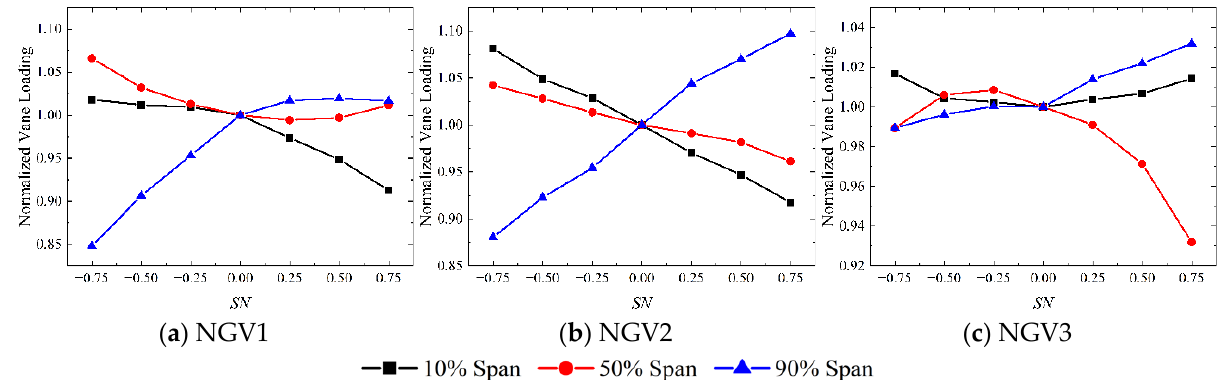
Figure 15. Effect of swirl intensities on NGV loading at different spans.